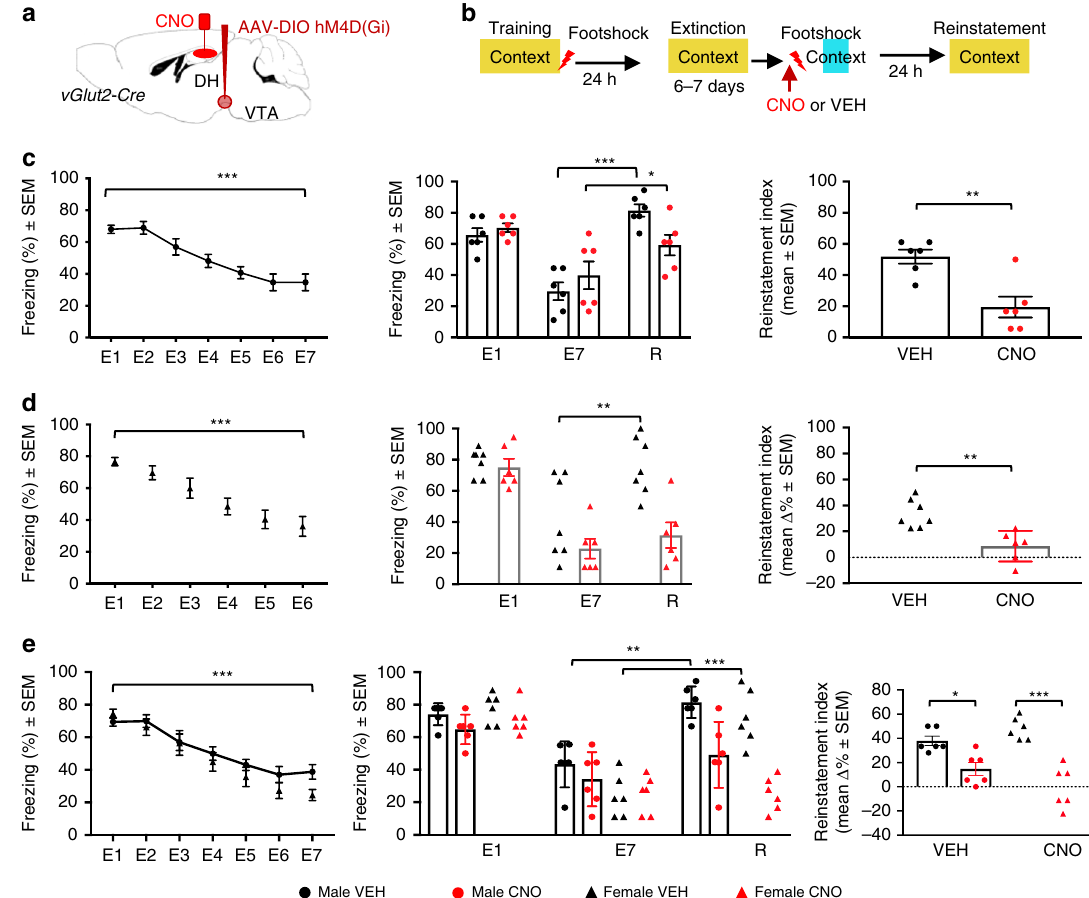
Fig. 3 Silencing glutamatergic VTA → DH terminals prevents fear reinstatement. a Schematic of virus infusion into VTA and cannulation in DH. b Behavioral paradigm with context-footshock conditioning followed by exposure to context until extinction. Footshock reminder was presented in a novel context and mice were re-tested for fear reinstatement in the conditioning context. c Left, extinction in vGlut2-Cre male mice [RM one-way ANOVA, F = 31.19, *** P < 0.0001]. Middle, comparison of freezing during the fi rst context test (E1), last extinction test (E7), and reinstatement test in (2.841, 31.25) mice injected with VEH ( n = 6) or CNO ( n = 6) before reminder shock. Signi fi cant treatment × test interaction [two-way ANOVA, F (2, 20) = 7.278, P < 0.0042] was found with stronger reinstatement in the VEH (*** P < 0.0001, n = 6) vs. CNO (* P = 0.0175, n = 6) group. Right, CNO reduced the fear reinstatement index (two-tailed unpaired t test, t 10 = 4.031, ** P = 0.0024). d Left, extinction in vGlut2-Cre females [RM one-way ANOVA, F (3.034, 36.41) = 17.96, *** P < 0.0001]. Middle, treatment × test interaction after reminder shock (two-way ANOVA, F (2, 22) = 8.316, P = 0.0020)), revealing signi fi cant reinstatement in the VEH (** P < 0.0002, n = 7) but not CNO group ( P = 0.4890, n = 6)]. CNO reduced the reinstatement index (two-tailed way ANOVA with Sex and Test, effect of Test, F (6, 132) = 47.69, *** P < 0.0001]. Middle, in mice treated with VEH or CNO before shock reminder,